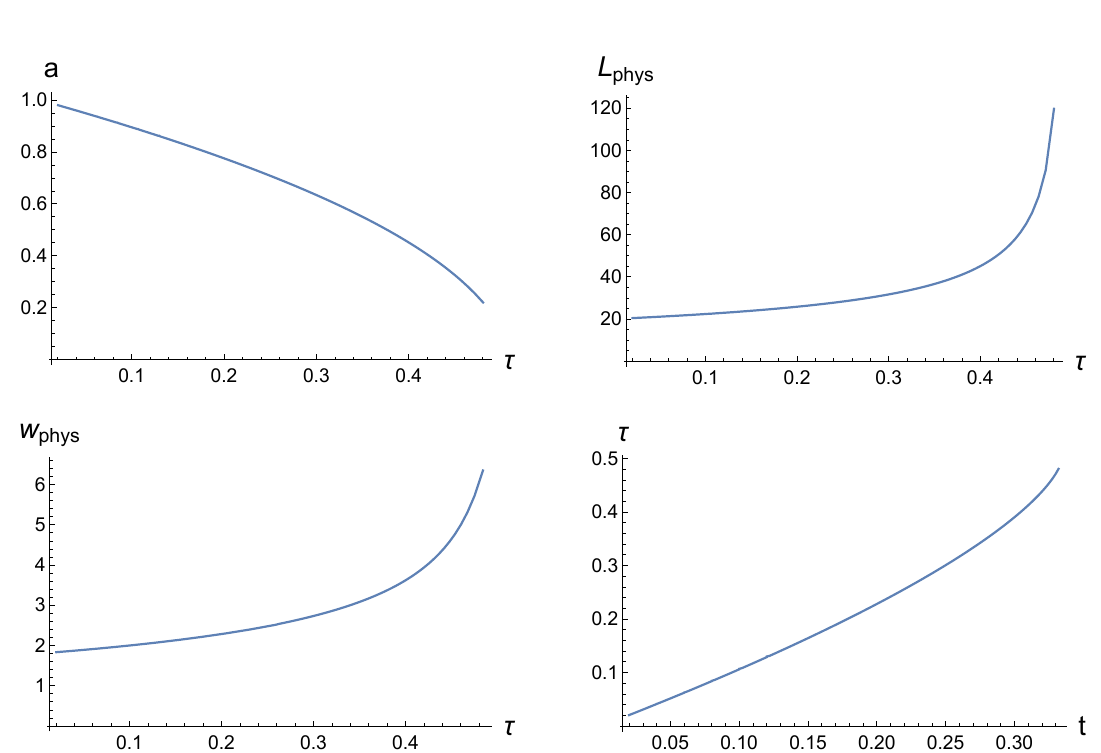
Figure 12 . The scale factor a , the physical size of the extra dimension L phys and the physical width of the domain wall w phys as functions of τ . The bottom-right plot shows the relation between t and τ . The parameters are chosen as V min = 0 and (4.6) except for b 0 = − 1